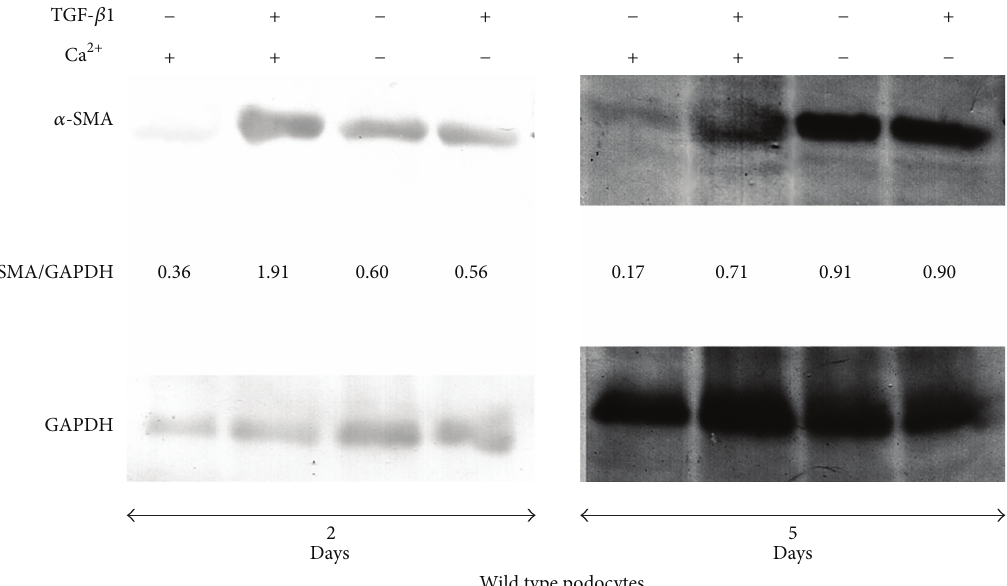
Figure 4: Effects of Ca 2+ deprivation and TGF- 𝛽 1 on 𝛼 -SMA expression in wild type podocytes. The cells were exposed to the indicated treatment and processed for western blot as specified in Section 2. The antibodies used are described in the previous figures. To quantify the protein bands, we scanned the blots and performed a densitometry analysis, using the software NIH ImageJ v. 6.4 (freeware, NIH, MD, USA). The figure shows a typical experiment of at least three performed under the same